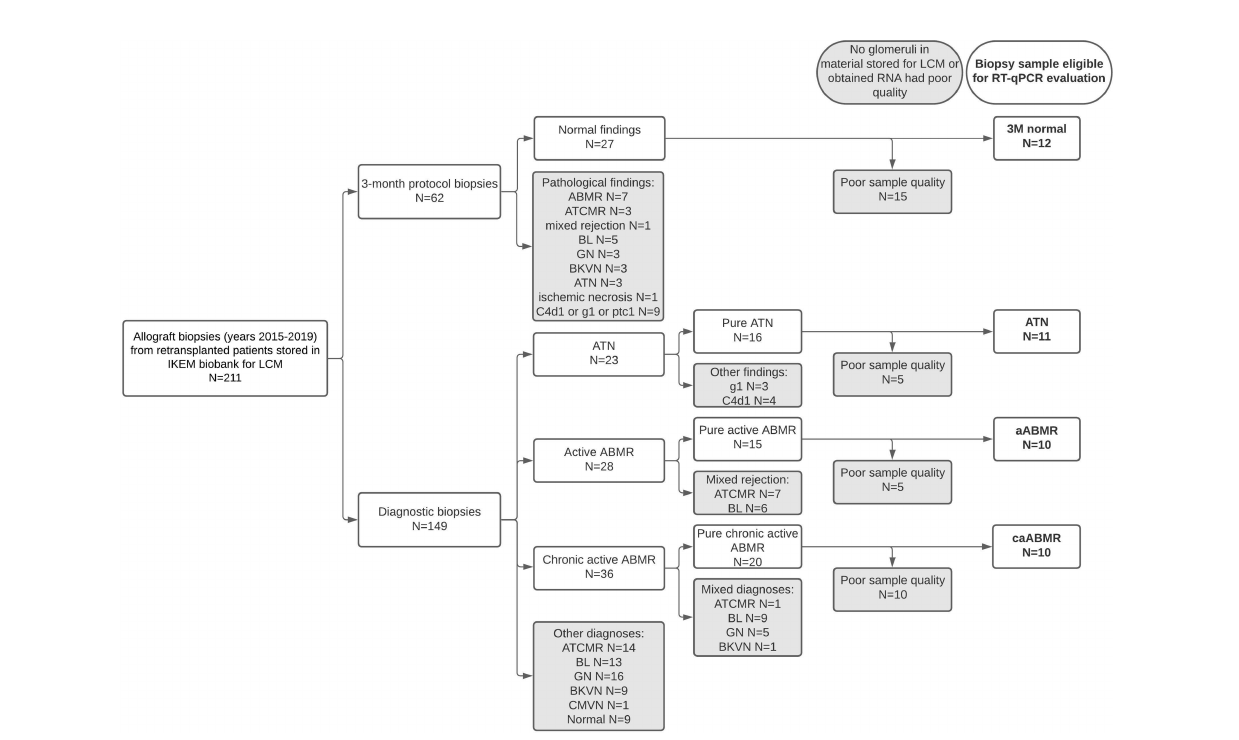
FIGURE 1 | Flowchart of samples selection. Only samples with pure diagnosis of active ABMR, chronic active ABMR, ATN and normal fi ndings in 3-month protocol biopsy, which had enough material for LCM and good RNA quality, were used for RT-qPCR form the biobank of biopsies from retransplanted patients. LCM, laser capture microdissection; ABMR, antibody-mediated rejection; ATCMR, active T-cell mediated rejection; BL, borderline lesions; GN, recurrence of glomerulonephritis; BKVN, BK virus nephropathy; CMVN, cytomegalovirus nephropathy; ATN, acute tubular